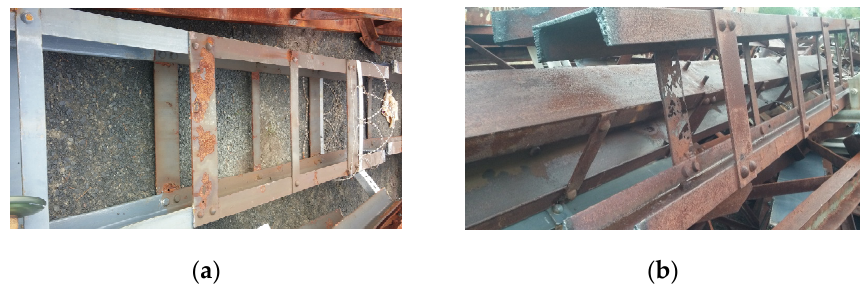
Figure 11. Demolished battened column. ( a ) bottom section, ( b ) Mid-section.